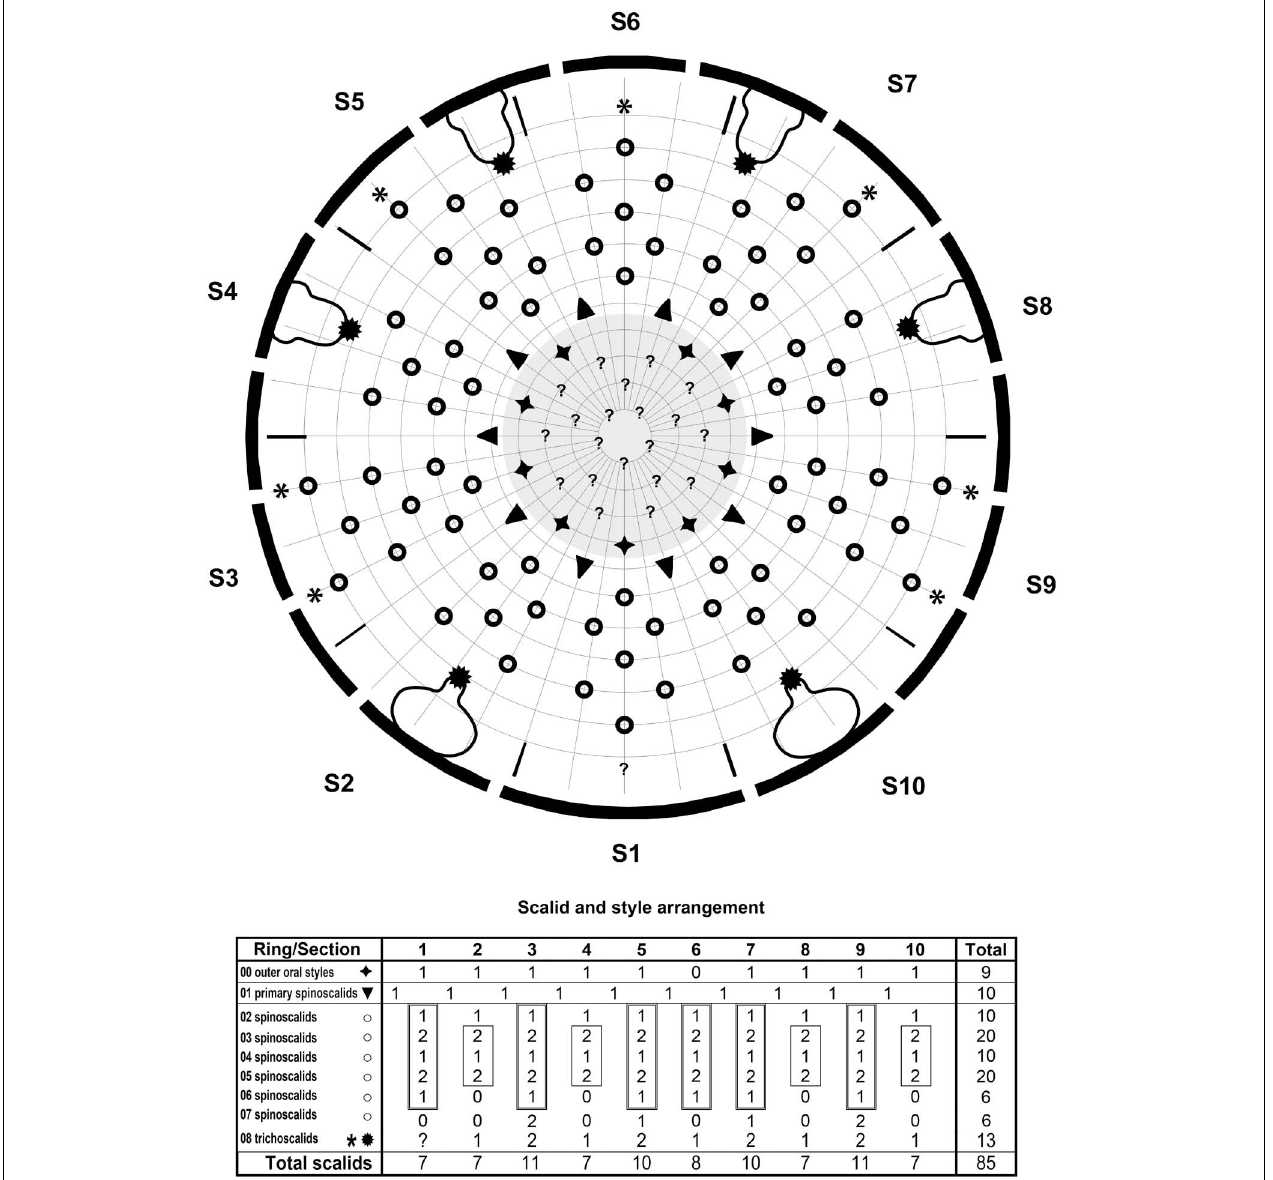
FIGURE 3 | Diagram of mouth cone (gray area), introvert, and placids in Echinoderes augustae sp. nov., showing distribution of outer oral styles, scalids, and trichoscalids. Table shows the scalid arrangement by sector; single-lined boxes mark quincunxes, double-lined boxes mark “double diamonds.”